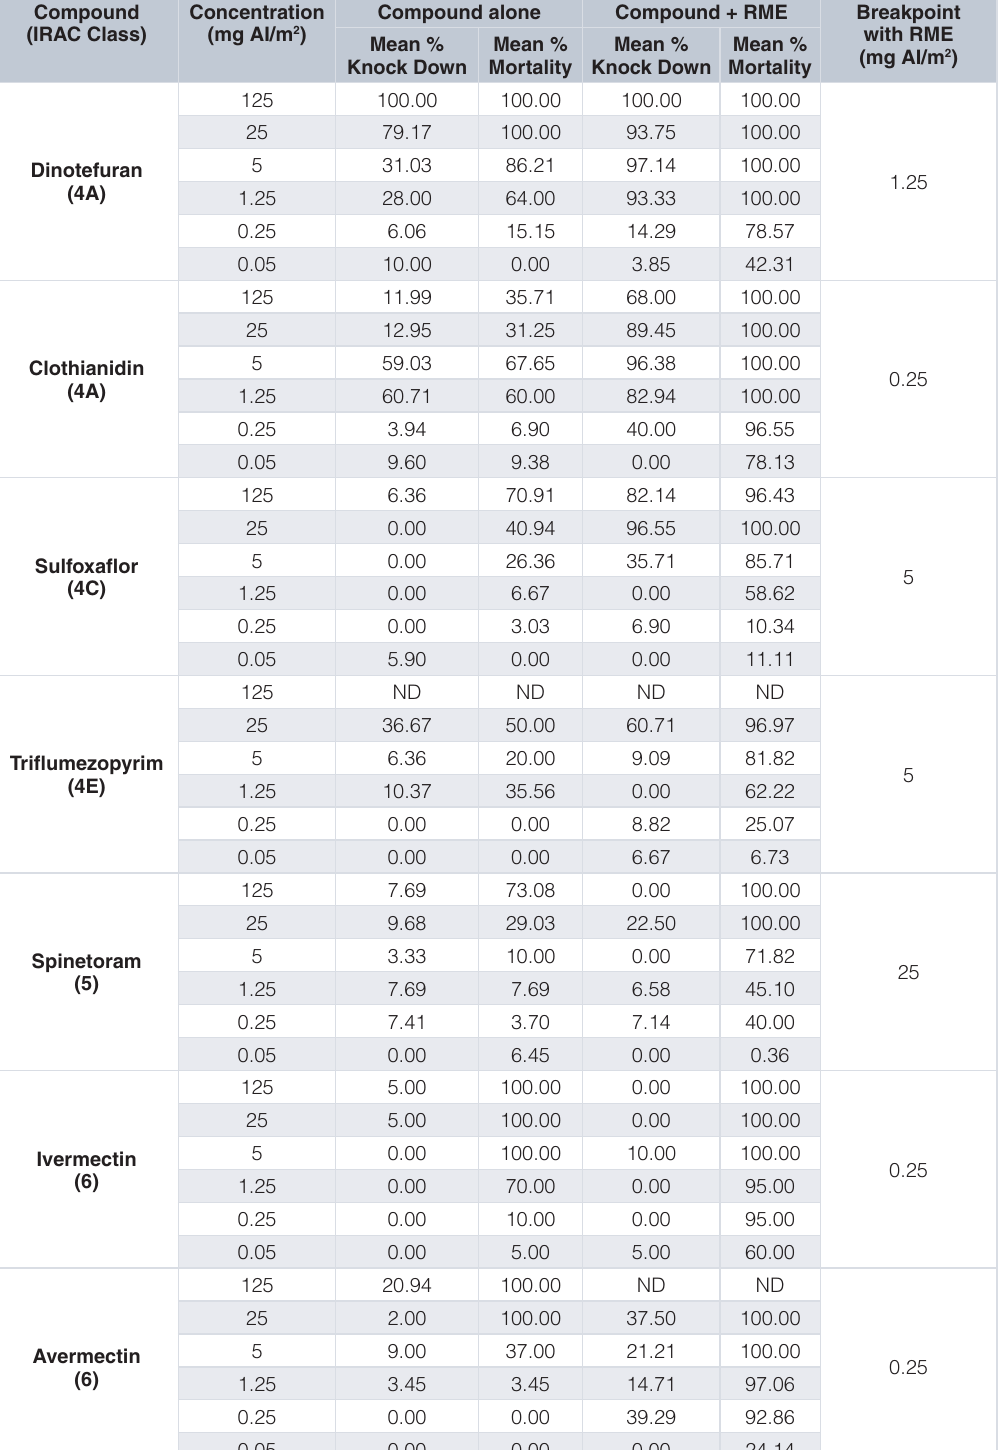
Table 2. Effect of tarsal contact with 20 compounds, with/without RME, on adult female Anopheles gambiae . There were 20 compounds applied in acetone to a glass plate and allowed to dry before mosquitoes were exposed to the surface and scored for knock down and mortality 60 minutes and 24 hours, respectively, after exposure. Percentages have been corrected for negative control mortality using Abbott’s formula (Abbott, 1925). Compounds indicated as being unclassified have not been listed by IRAC (2018). ND indicates a data point which was not